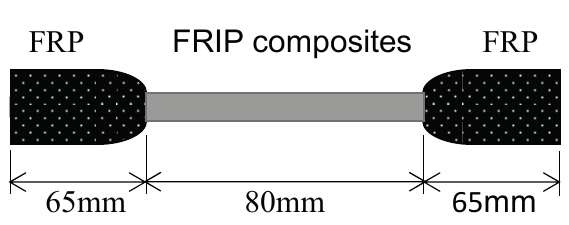
Figure 3. Tensile test